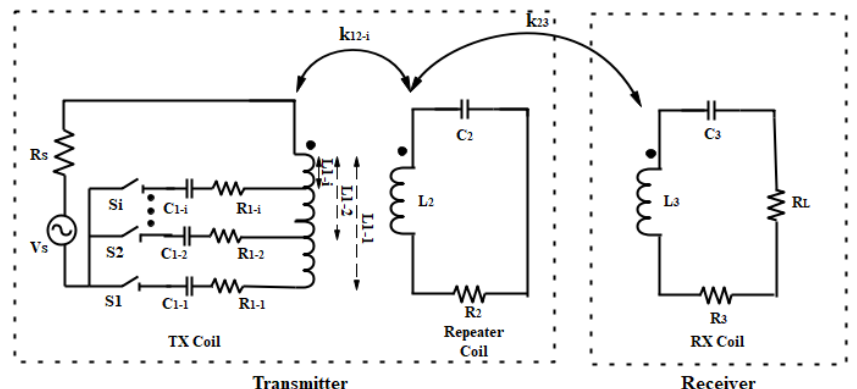
5 of 15 Figure 3. Simplified schematic diagram of the proposed reconfigurable three-coil IPT system. 3.2. Circuit Model Figure 4 shows a lumped circuit model of the proposed three-coil IPT system. Differ-